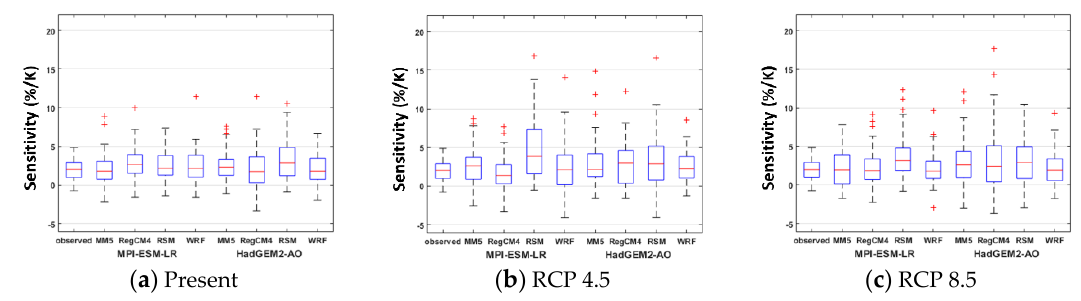
Figure 15. Sensitivity of annual exceedance daily rainfall depth to DPT.